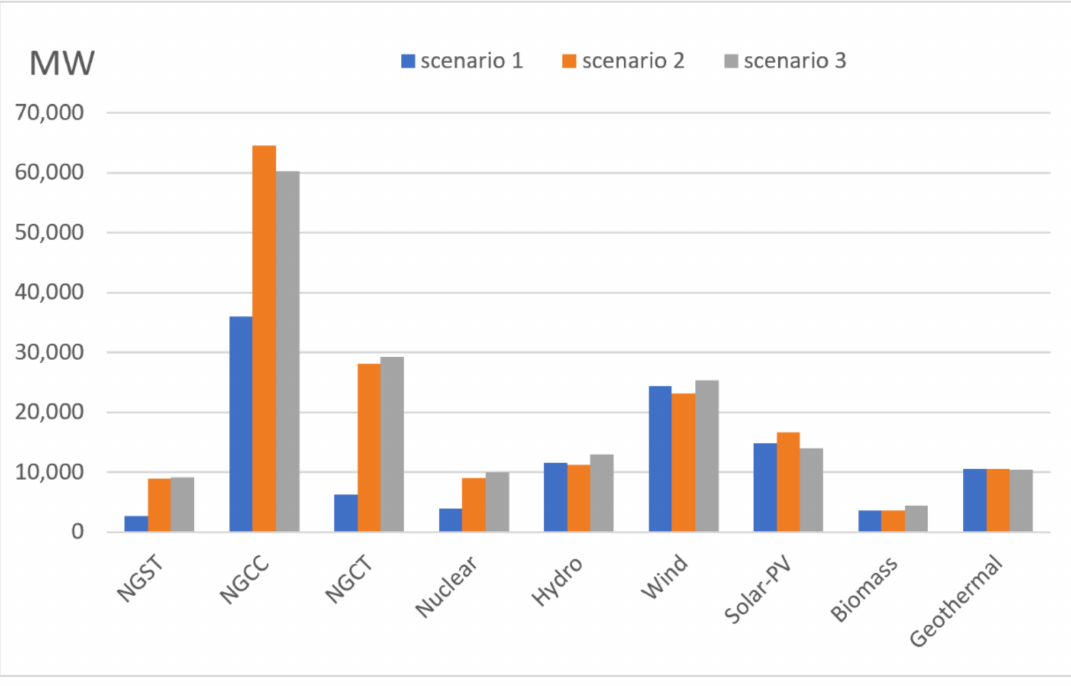
Figure 7. The total cumulative capacity of each power plant in all scenarios in